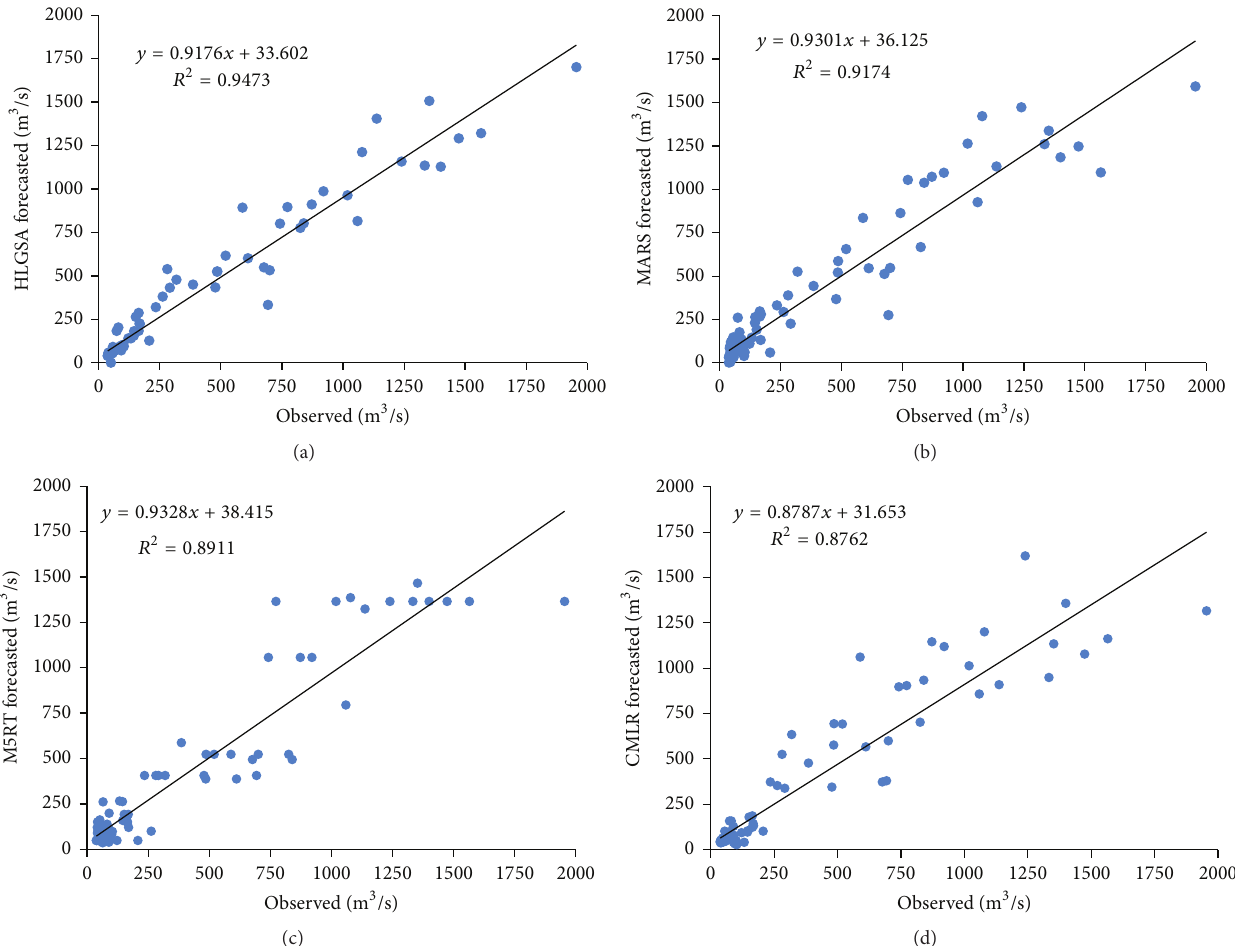
Figure 8: The observed and forecasted river flow by the HLGSA, MARS, M5RT, and CMLR models using DS3 data set: Shyok catchment.